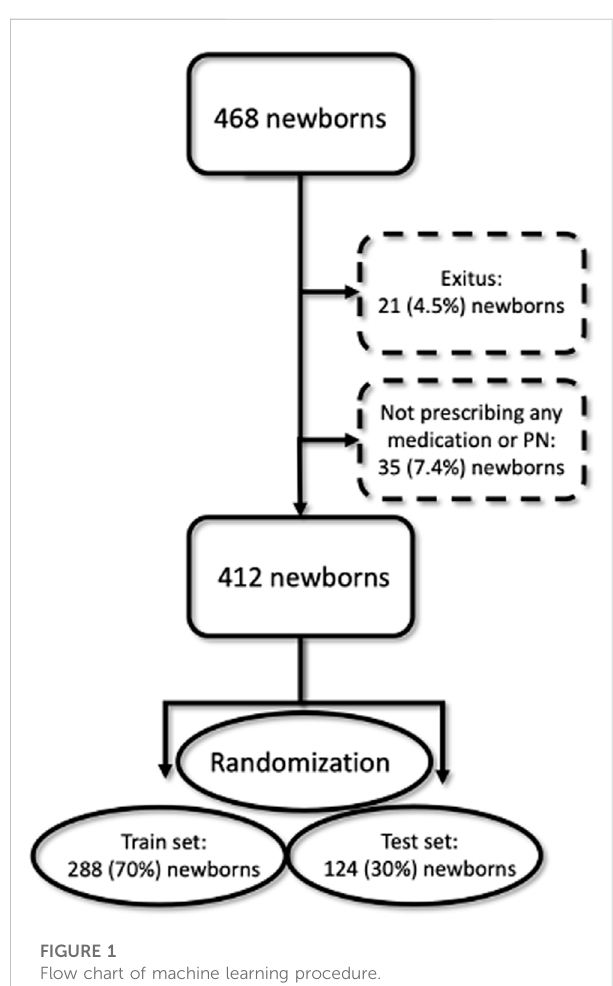
FIGURE 1 Flow chart of machine learning